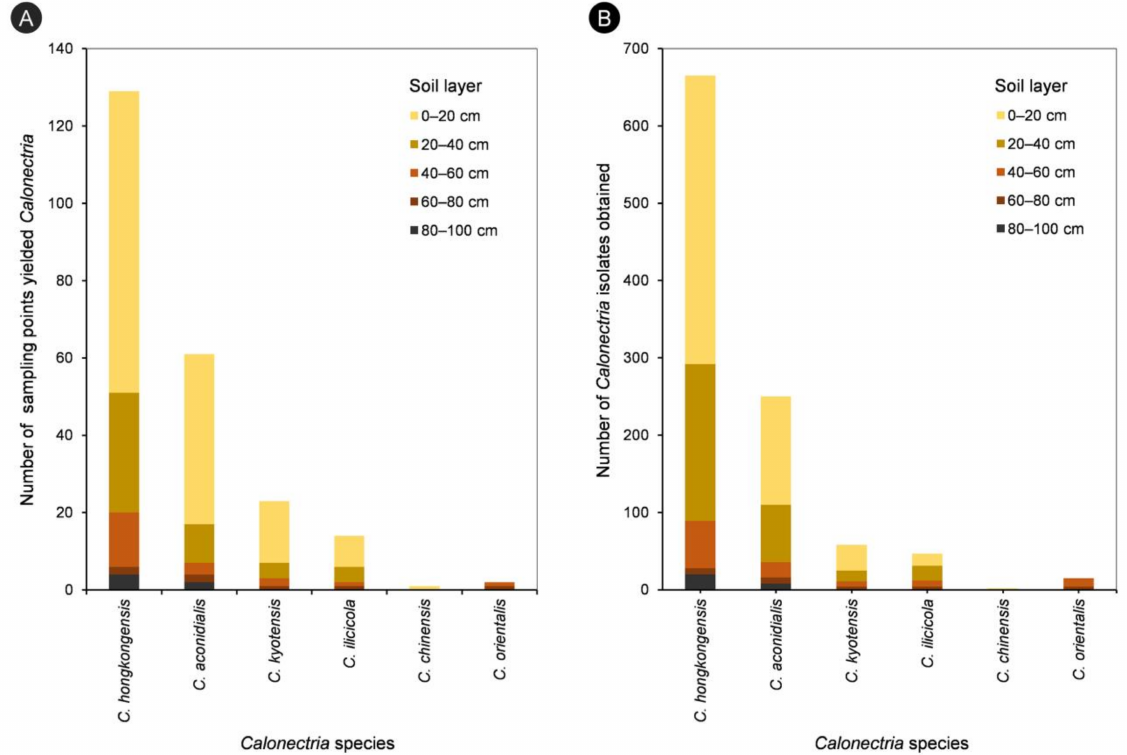
Figure 4. Number of sampling points yielded different Calonectria species in each of the five soil layers ( A ), and numbers of isolates obtained for different Calonectria species in each of the five soil layers ( B